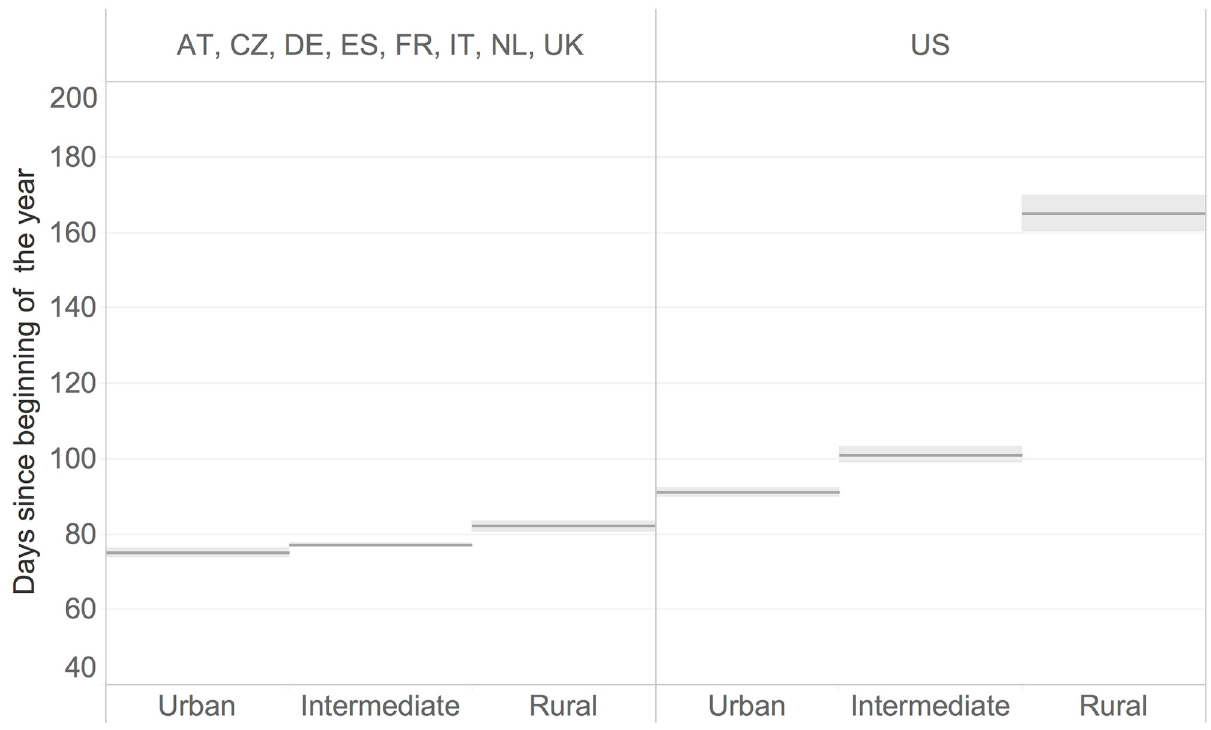
Fig 1. Onset of the pandemic across regions by rural-urban